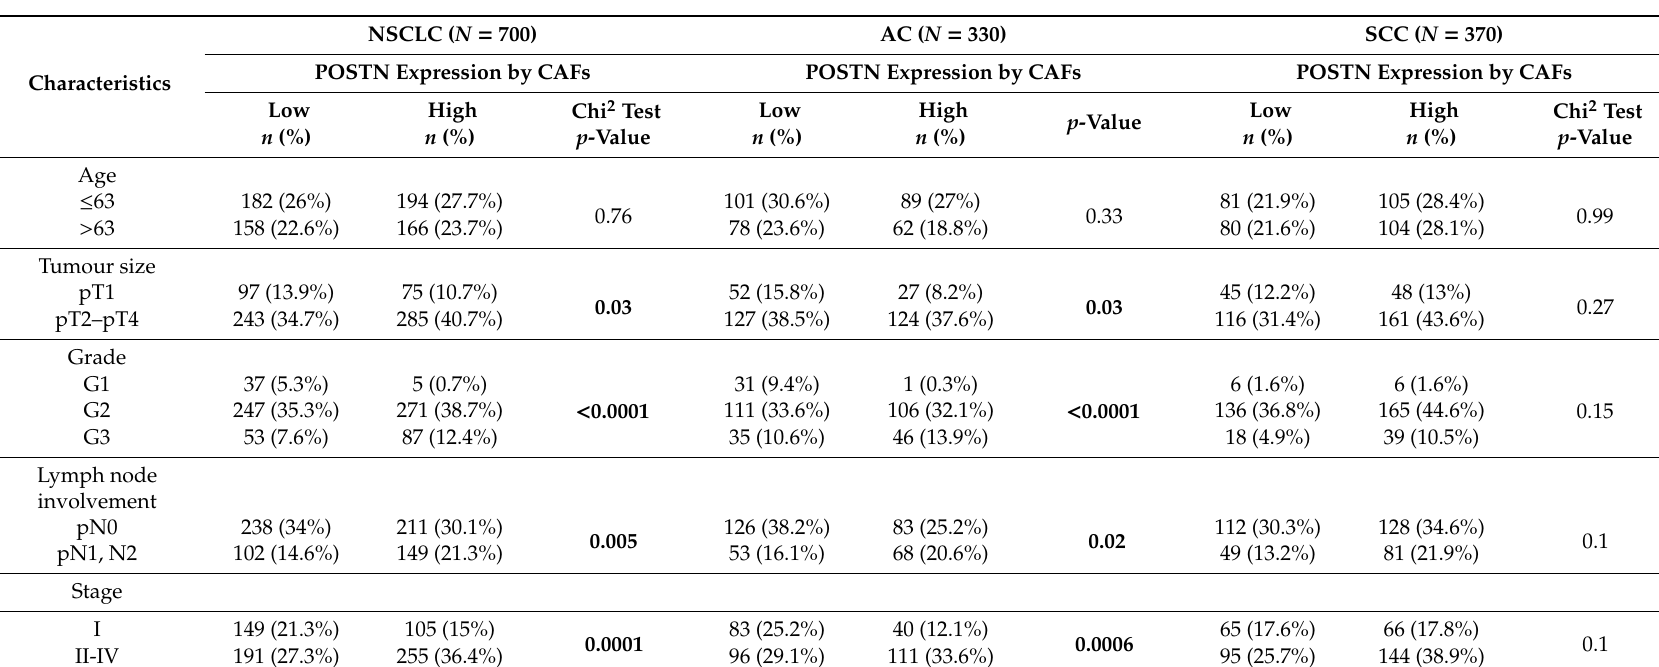
Table 2. Relationship between periostin (POSTN) expression in the stromal cells (CAFs) and selected clinicopathological parameters in non-small cell lung cancer (NSCLC) patients and in two histological subtypes: adenocarcinoma (AC) and squamous cell cancer (SCC).